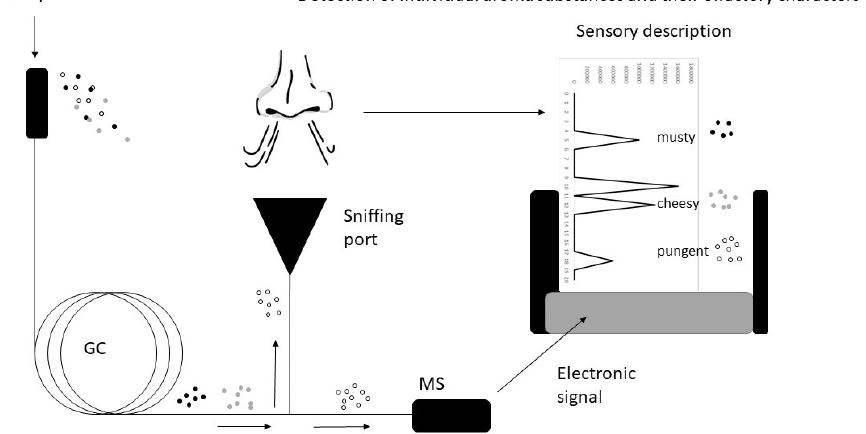
Figure 2. Overview of the gas chromatography–olfactometry system (modelled after [32]).